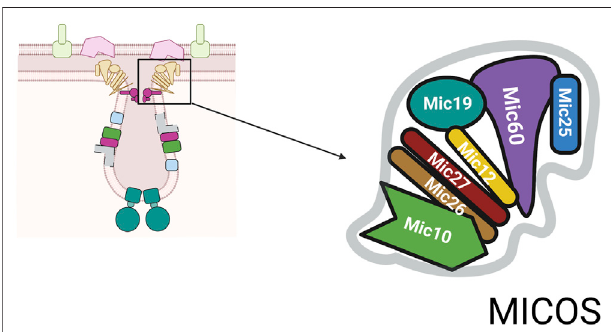
FIGURE 2 | MICOS complex. The MICOS complex consists of multiple proteins named for their molecular weight. The numbers shown are based on mammalian system and are slightly different in yeast